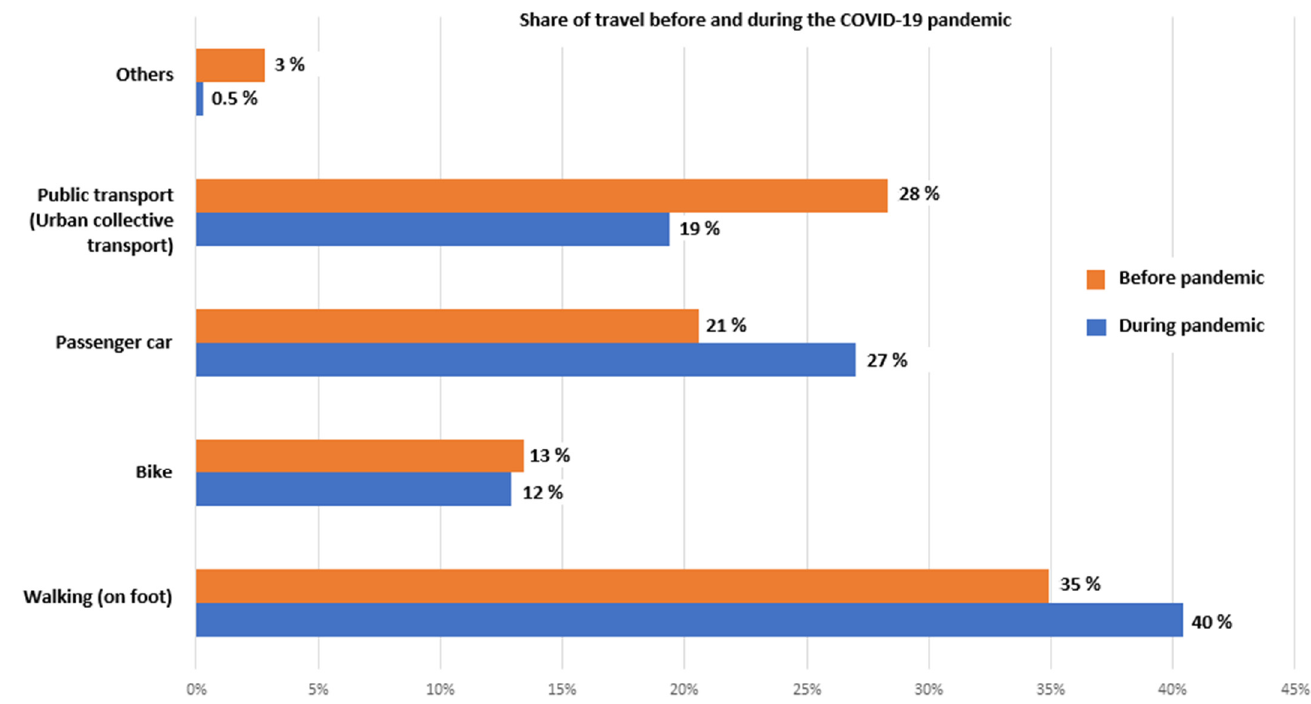
Figure 7. Share of travel before and during the COVID-19 pandemic. Source: based on [4]. It should be added that the reduction in public transport trips was caused not only by a general decrease in mobility (Figure 8), but also by numerous pandemic restrictions on access to urban collective transport, resulting from the limit of seats occupied in vehi- cles.